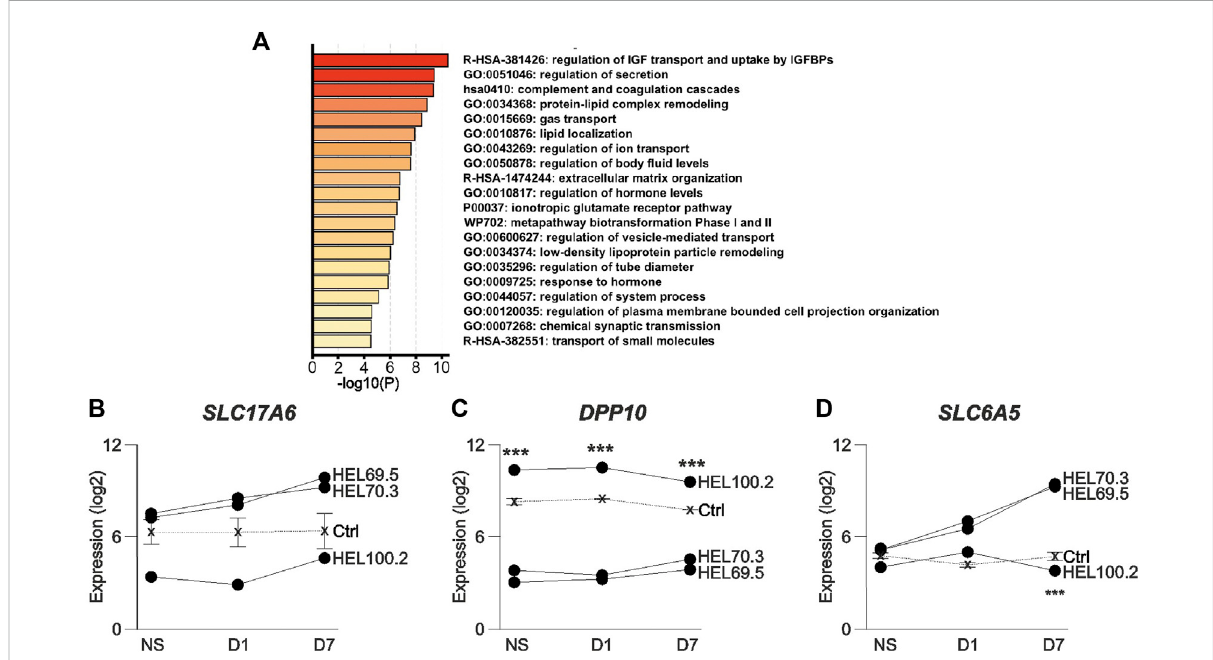
FIGURE 5 Pathway analysis and expression of genes associated with the mouse audiogenic seizure phenotype in human FXS NPCs generated from the donor with epilepsy and from donors without epilepsy. (A) Pathway gene enrichment analysis of differently expressed genes in HEL100.2 and other FXSNPCsinD7NPCs. (B) SLC17A6, (C) DPP10 ,and (D) SLC6A5 expression inneurosphere(NS),Day1(D1),andDay7(D7)NPCs derivedfromtheFXS male donor with epilepsy (HEL100.2) and from FXS male donors without epilepsy (HEL70.3 and 69.5). Expression levels of three control iPSC- derived NPCs are shown with a dashed line. Data are shown as means ± SEM. p -values were adjusted with the method of Benjamini and Hochberg (Benjamini and Hochberg, 1995). *** p < 0.001 when comparing HEL100.2 and other FXS (HEL70.3 and 69.5)